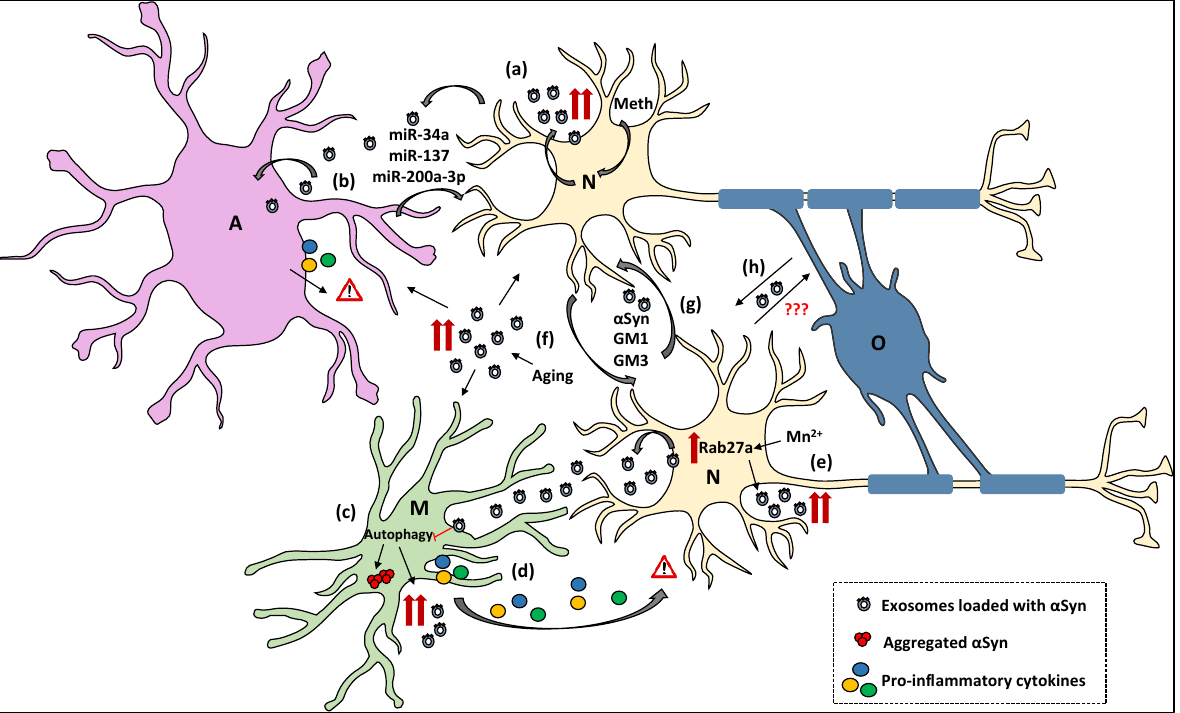
Figure 2. Pathological role of neuronal and glial exosomes in alpha-Synucleinopathies. ( a ) Metham- phetamine triggers the release of exosome- associated pathological αSyn from stressed neurons (N, yellow), which is then transferred to astrocytes (A, purple), causing inflammatory responses. ( b )